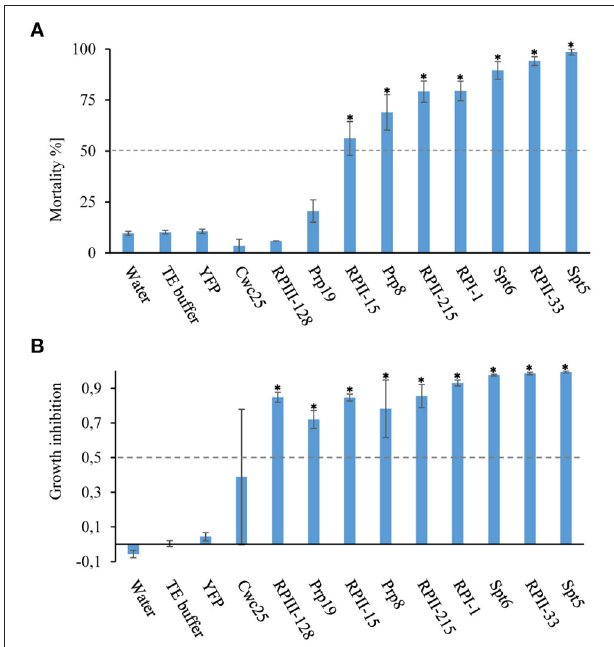
FIGURE 4 | Mortality rates and GI value of D. v. virgifera after knockdown of genes involved in the process of transcription. Neonate D. v. virgifera larvae were fed on artificial diet that was surface-overlaid with dsRNA at 500 ng/cm 2 . Yellow fluorescent protein gene (YFP) dsRNA, 0.1X TE buffer and water were used as negative controls. (A) Mortality and (B) growth inhibition (GI) were evaluated after 9 days. See Supplementary Table 1 for number of replicates and standard error of the mean. Asterisks show statistical difference ( p < 0.001) (Missing, need to be included). The data represent three biological replicates ( n = 10 for each replicate). The results were analyzed with analysis of variance (ANOVA) ( Supplementary Table 1 ).